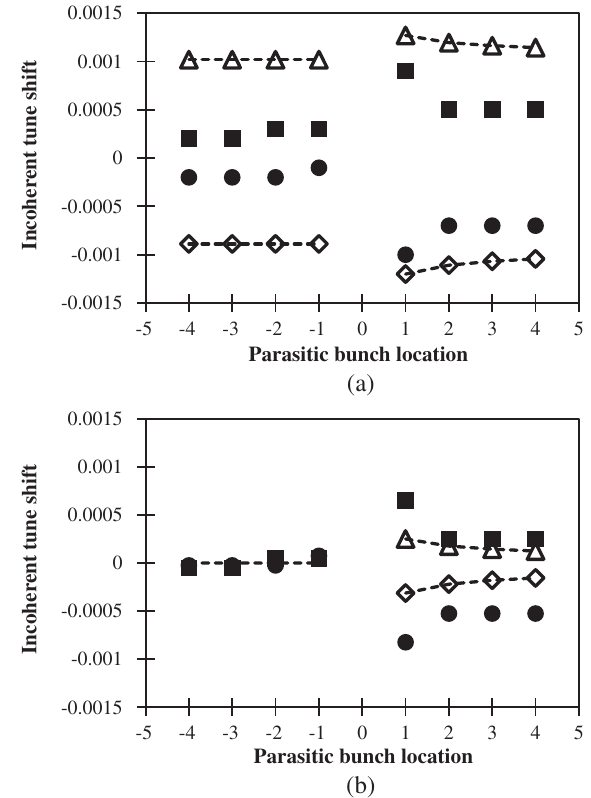
FIG. 5. Horizontal (black square) and vertical (black circle) tune shifts measured on the eight parasitic bunches for a 20 mA main bunch. Horizontal (white triangle) and vertical (white diamond) incoherent tune shifts calculated with model A. (a) Raw data. (b) With mean long-range tune shifts of the upstream bunches